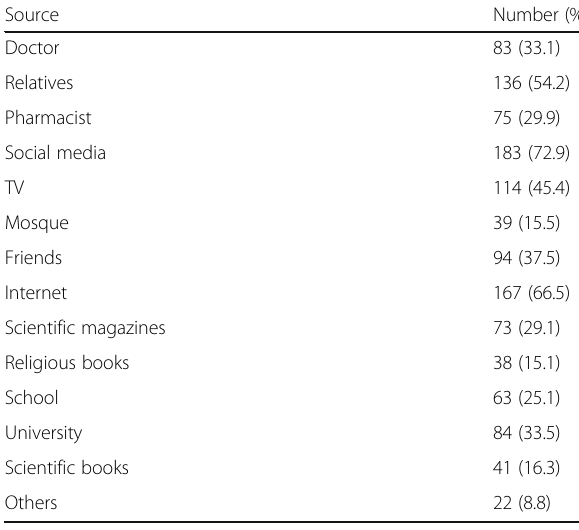
Table 6 Information sources used by participants as their source of knowledge on complementary and alternative medicine